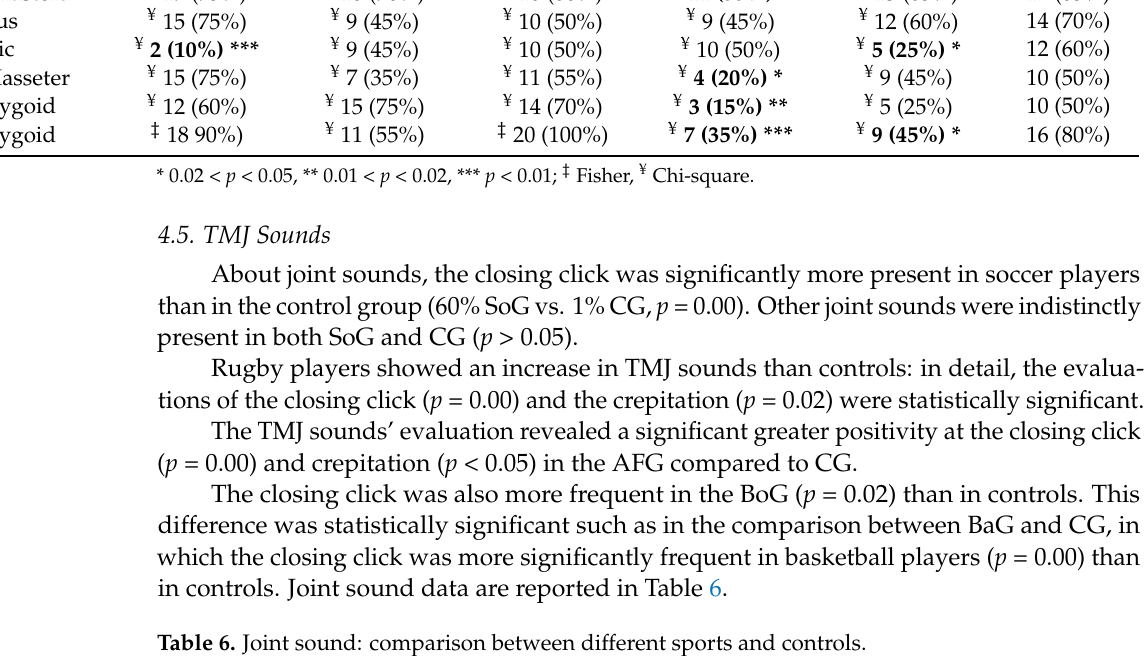
Table 6. Joint sound: comparison between different sports and